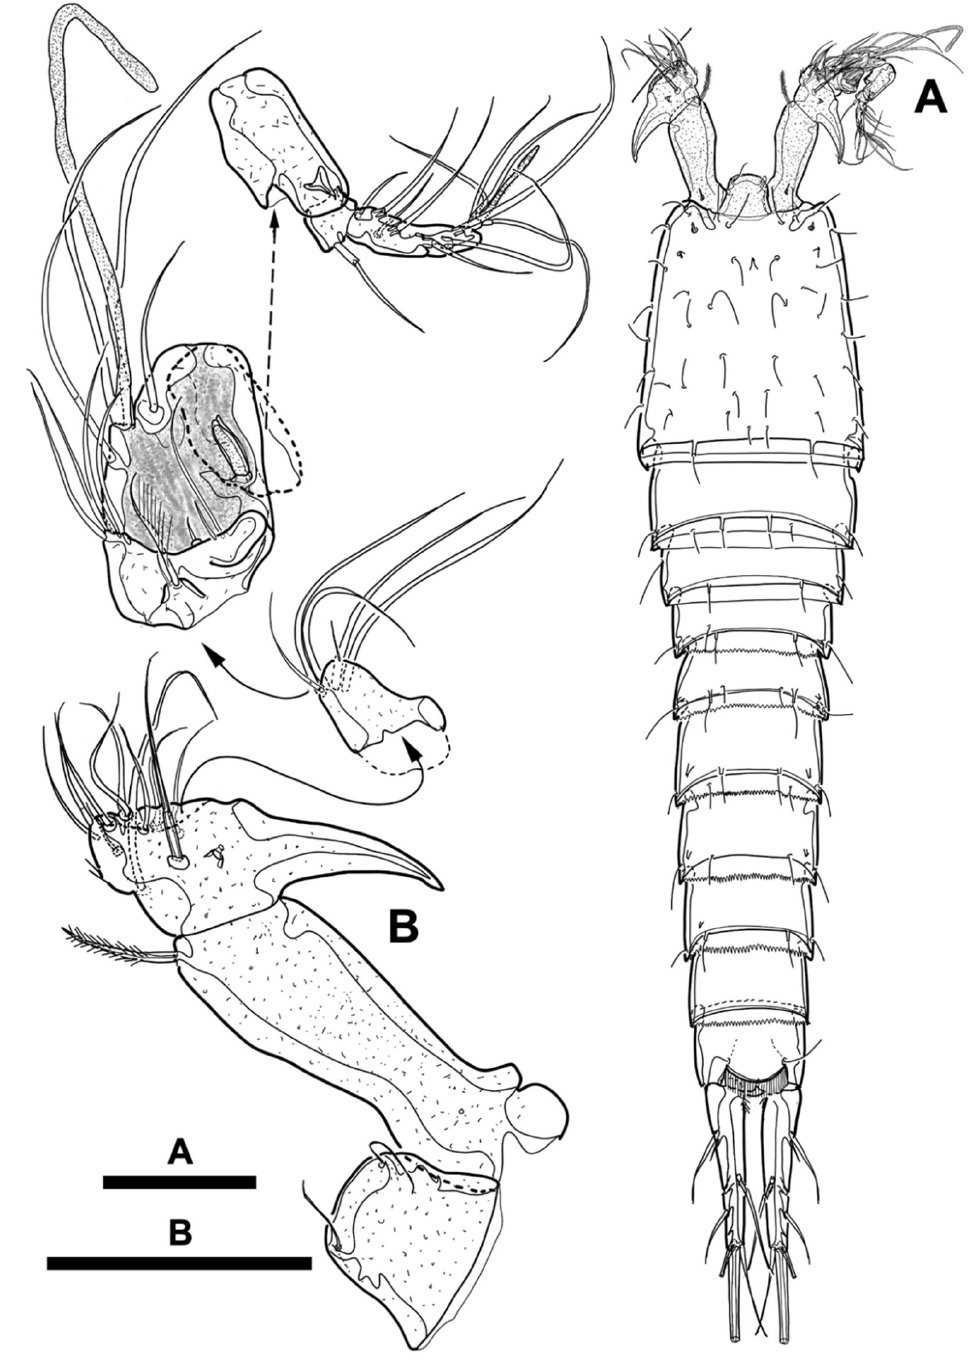
Figure 17. Line drawings of Phyllopodopsyllus saywakimi sp. nov. male (paratype 14): ( A ) habitus, dorsal; ( B ) rostrum and antennule, dorsal. Scale bar: ( A ) 100 µm; ( B ) 50 µm.